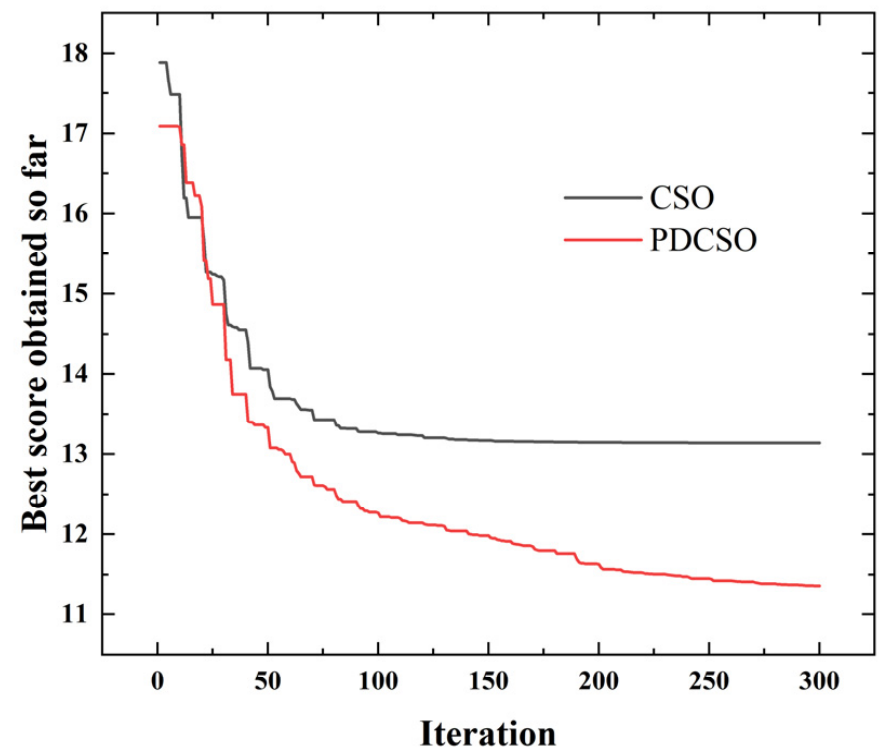
Figure 8. Comparison of iterative convergence.